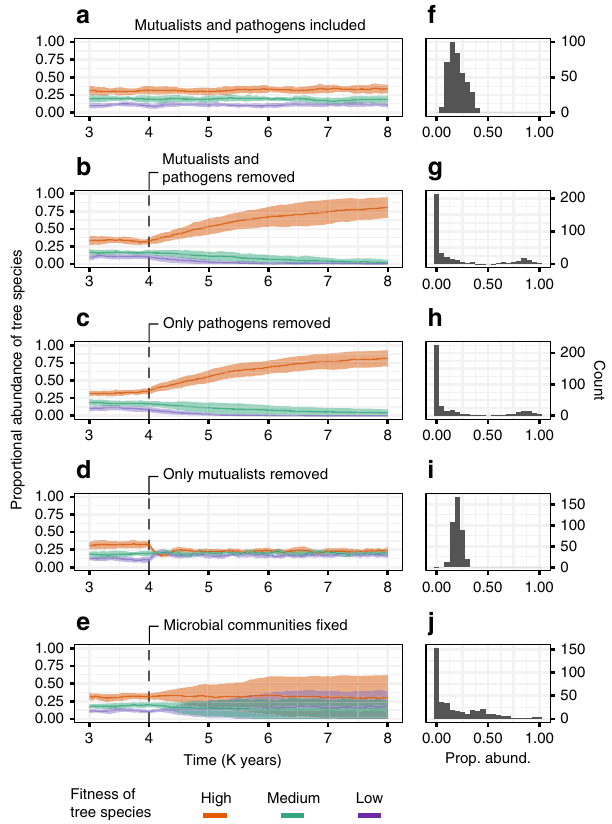
Fig. 4 Plant population dynamics with and without microbial dynamics. Panels ( a ) through ( e ) each show the average population dynamics of plant species. Average dynamics (mean abundance±s.d. encompassed by each shaded band, n = 16 independent simulation runs) are shown only for the three plant species with high fi tness, medium fi tness, and low fi tness. Panels ( f ) through ( j ) show the resulting frequency distributions of plant abundance, which include all fi ve species from 16 runs. For panels ( f ) through ( j ), abundance values were pooled across runs. a Runs were conducted using the parameterization shown in Table 1. b Runs conducted as in ( a ), but after 4K years, all effects of mutualists and pathogens on plant recruitment were removed from the simulation. Panel ( b ) therefore represents the dynamics expected without plant-soil feedback; the species with highest fi tness goes to fi xation. c All pathogens were removed after 4K years. Feedback dynamics without pathogens are similar to those with no feedback. d All mutualists were removed after 4K years, but pathogens were kept in the system. Without mutualists, the most abundant and least abundant plant species shared more similar equilibrium abundances. e Microbial communities were fi xed on each plant species. I.e. after 4K years, each new recruit of a given plant species was assigned a speci fi c microbial community representing the mean microbial community on individuals of that host species after 4K years. These fi xed microbial communities did not change through time once assigned. Panel ( e ) illustrates the dynamics that would be expected if each plant species supported a species-speci fi c microbial community that does not change through time. Population dynamics in two dimensions are expected to occur at a faster rate than the one-dimensional population dynamics displayed here 51 . Relationships between microbial traits and simulation dynamics . Conducting many individual simulations (16 K) that were parameterized using random values of our target variables allowed us to characterize the importance of each model para- meter (including microbial traits) as a determinant of model behaviour. Here, we report the results of three random forest classi fi cation models 30 that measure the contribution of